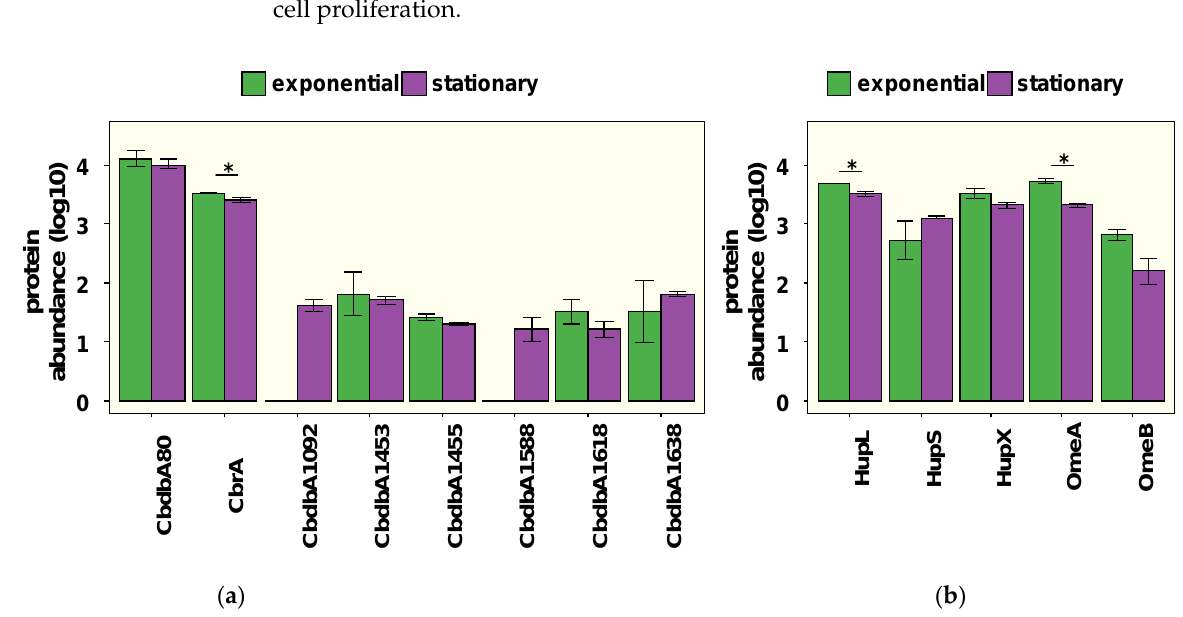
Figure 3. Median-normalized protein abundances of RdhAs ( a ) and other components of the OHR complex ( b ) in the exponential and stationary growth phases of the first experiment. The small, extremely hydrophobic RdhB proteins were not detected in any proteome analysis. Mean values and standard deviations of triplicate cultures are shown; id, identified in one replicate; *, Benjamini–Hochberg adjusted p -values <0.05.